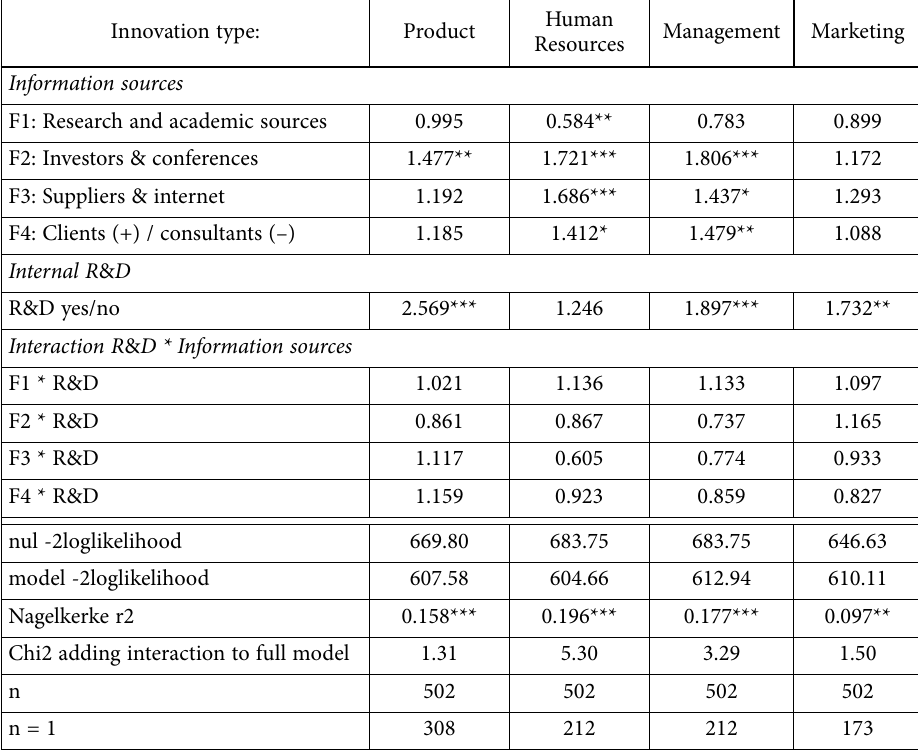
Table 4. Interactions between R&D and information